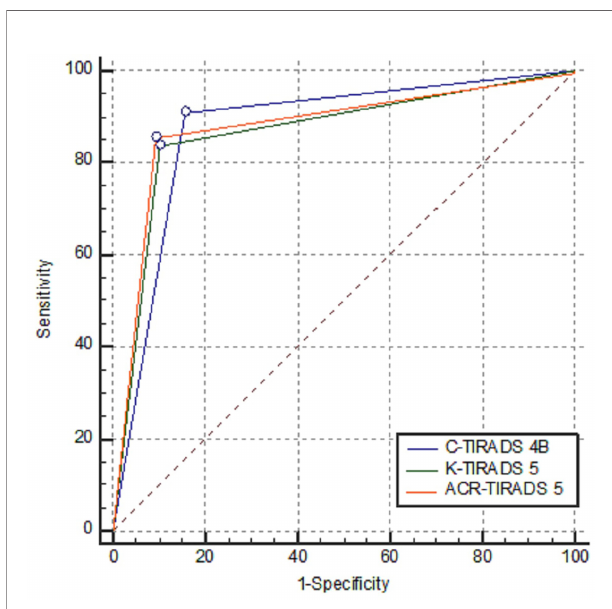
FIGURE 6 | Comparisons of AUCs of C-TIRADS 4B, K-TIRADS 5 and ACR- TIRADS 5. There was no signi fi cant difference between each pair of them ( Z value was 1.402, 0.306 and 1.004, respectively; and P value was 0.1610, 0.7593 and 0.3155,